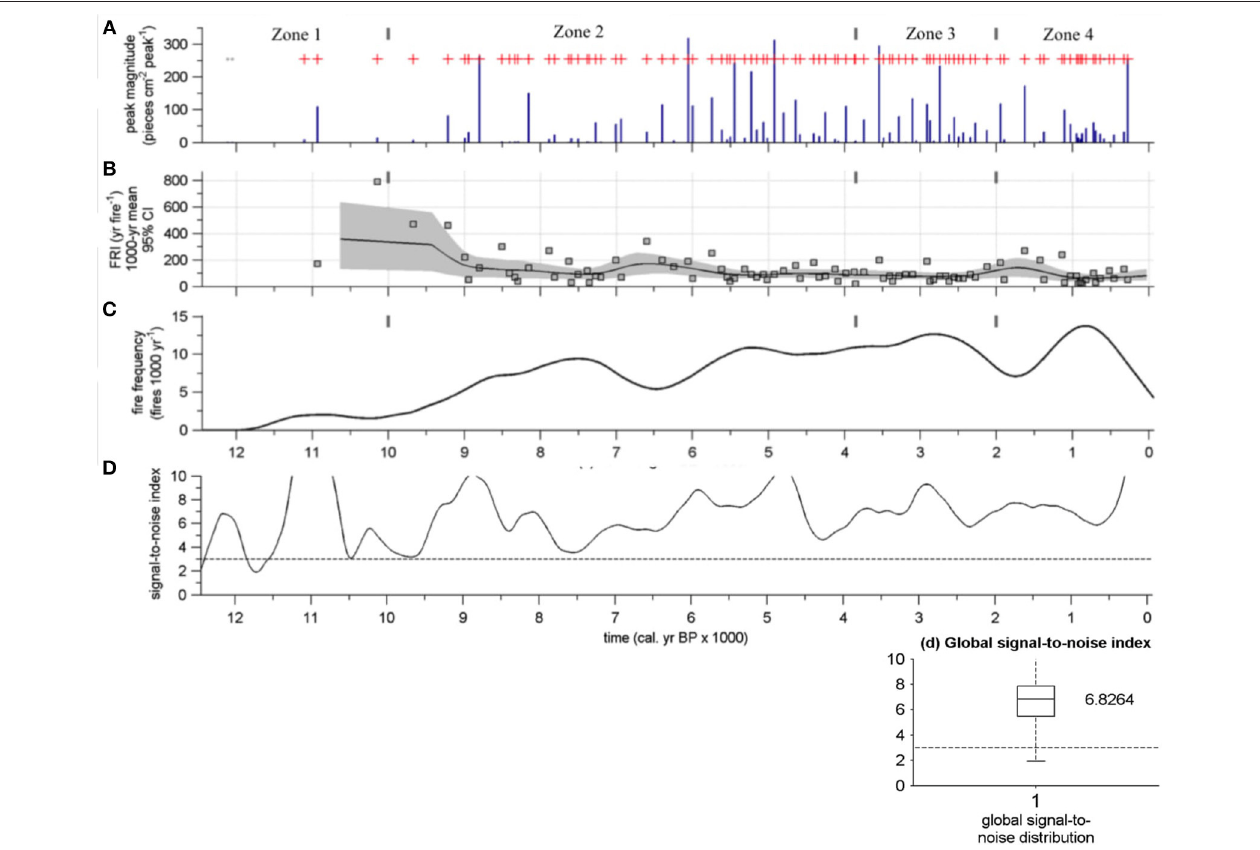
FIGURE 5 | Mean fire return interval and confidence intervals for the four different pollen zones. Distribution of fire return intervals (20-year bins) and Weibull model estimates (b and c parameters with 95% CI).